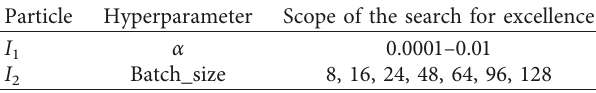
Table 1: Network model hyperparameter settings.